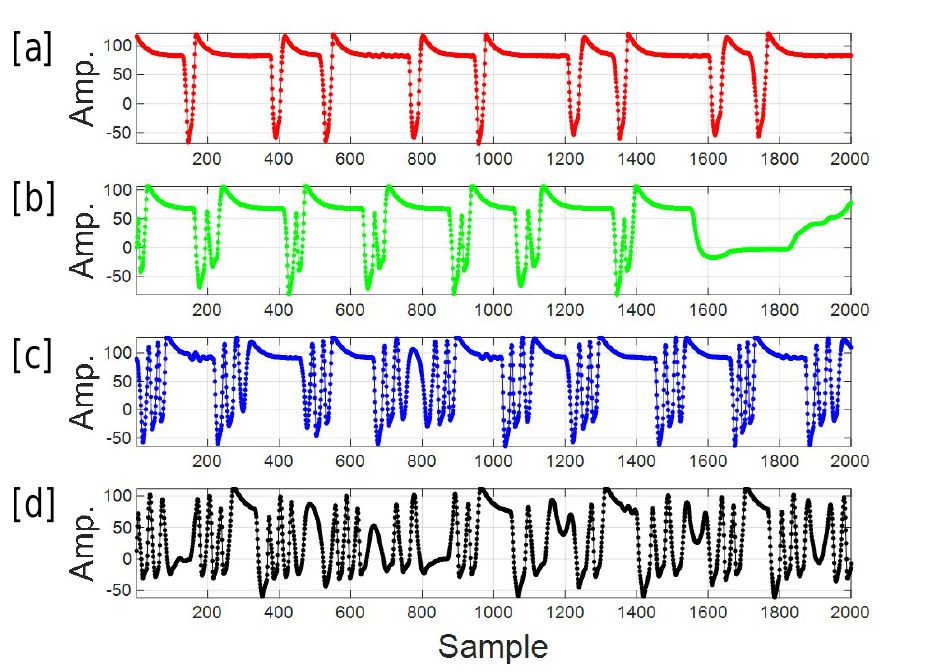
Figure 7. Captured Rx signal by the photodiode from top: ( a ) one-finger, ( b ) two-finger, ( c ) three- finger, and ( d ) four-finger